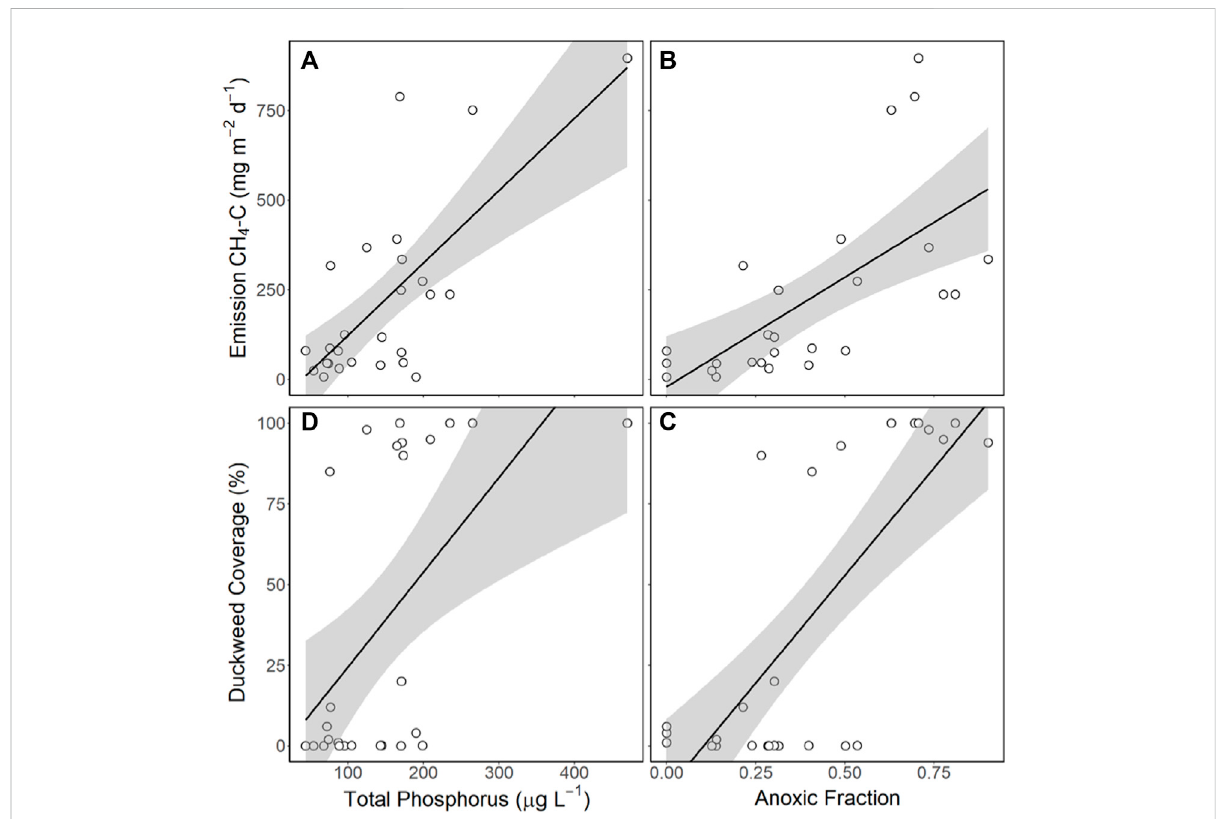
FIGURE 2 CH 4 emissions and duckweed coverage were both signi fi cantly correlated with total phosphorus and anoxic fraction. Scatterplots show signi fi cant correlations for all ponds ( n = 26) between (A) CH 4 emission rate and total phosphorus (y = 2.02x — 79.33, R 2 = 0.51, p < 0.0001) (B) CH 4 emission rate and anoxic fraction (y = 611.34x — 20.85, R 2 = 0.44, p = 0.0002 (C) duckweed coverage and total phosphorus (y = 0.29x — 4.94, R 2 = 0.32, p = 0.0028), and (D) duckweed coverage and anoxic fraction (y = 133.3x - 13.87, R 2 = 0.51, p <